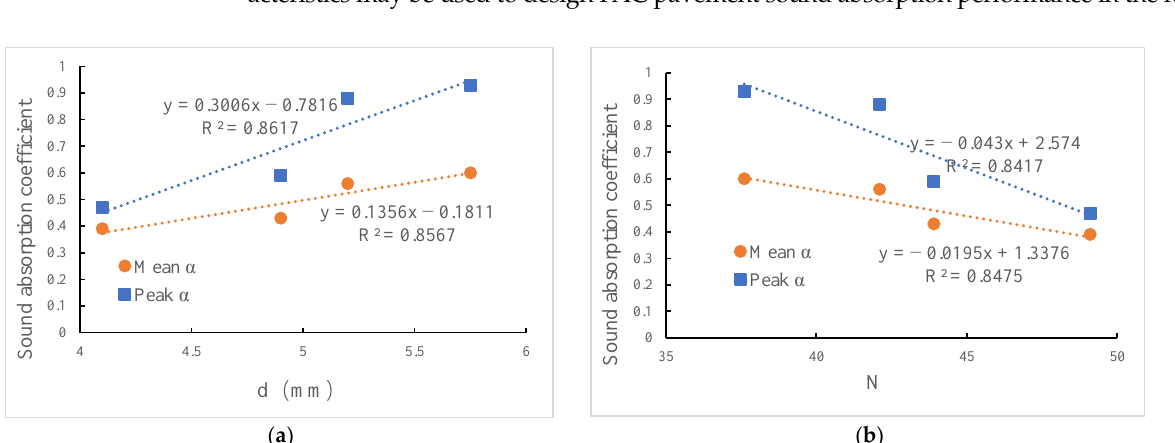
Figure 6. The relationship between the SAC and the parameters of size and number: ( a ) Relationship between SAC and 𝑁 ; ( b ) Relationship between SAC and 𝑑 . The geometric complexity of the void structure is described by the fractal dimension. Figure 7 shows the relationship between the void content and the average fractal dimen- sion of all images of each sample. As the void content increases, 𝐷 𝐵 increases, showing that as the complexity of the void morphology improves, the structure of the internal voids of the PAC becomes more complicated and the internal roughness rises.